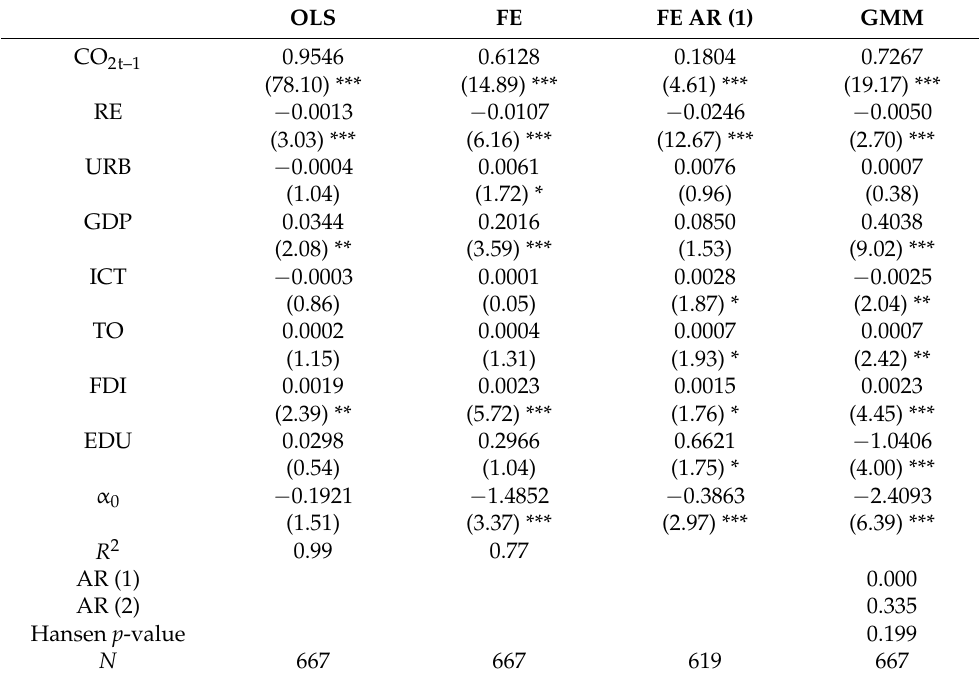
Table 2. Main results: CO 2 emissions per